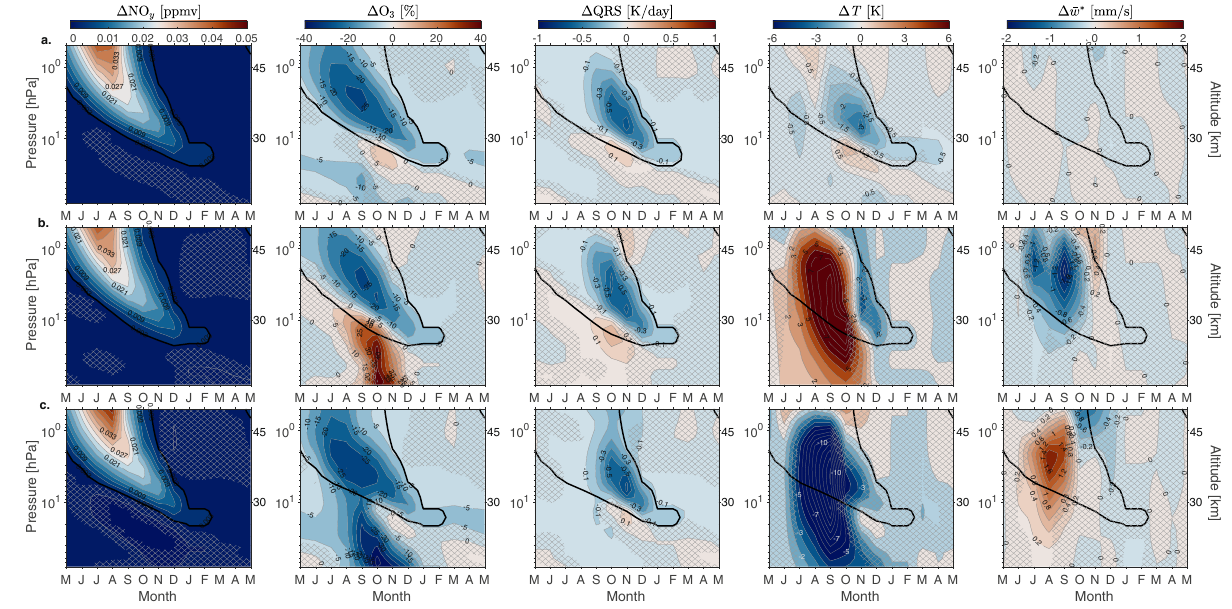
Fig. 5 | Time-slice sensitivity experiment. Monthly mean differences of SH polar (60 – 90°S) nitrogen family, NO y (NO x , HNO 3 , N 2 O 5 , ClONO 2 , HNO 4 ), ozone (O 3 ), shortwaveheatingrate(QRS),temperature( T )andresidualverticalwind( w * )(from left to right) for the idealized experiments labeled FW max and FW min : ( a. ) FW max - FW min , ( b. ) FW max -FW min for years with strong negative residual vertical wind dif- ferences, w * (downwelling), and (c.) FW max -FW min for years with strong positive residual vertical wind differences, w * (upwelling). Hatching indicates areas not